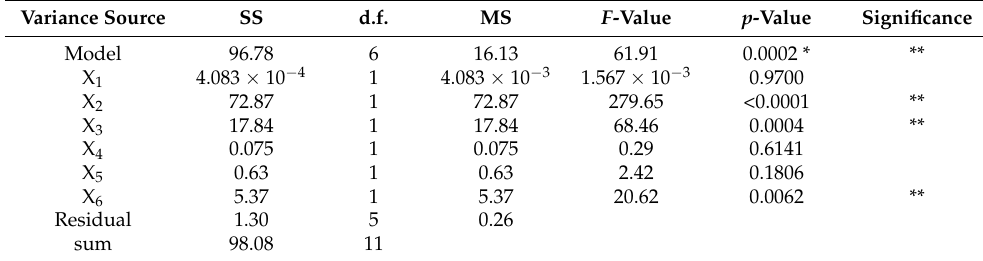
Table 4. Analysis of variance in Plackett–Burman experimental